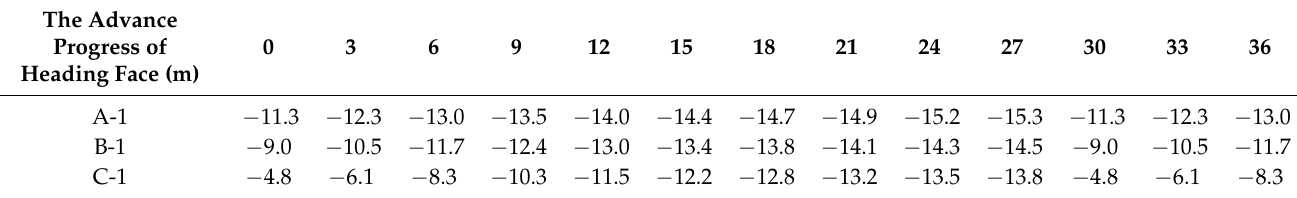
Table 7. Settlement deformation trend of arch crown (Unit: